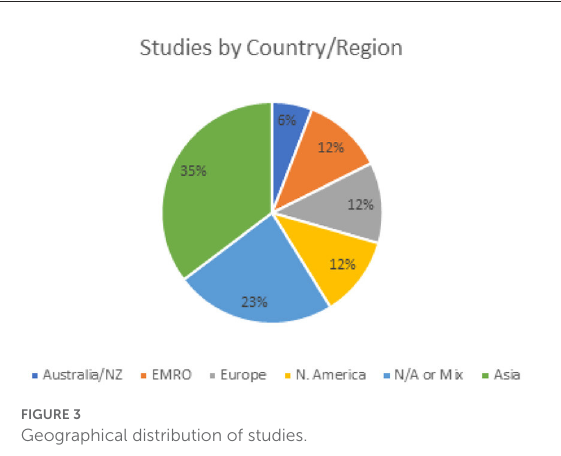
FIGURE2 Studies by methods type.